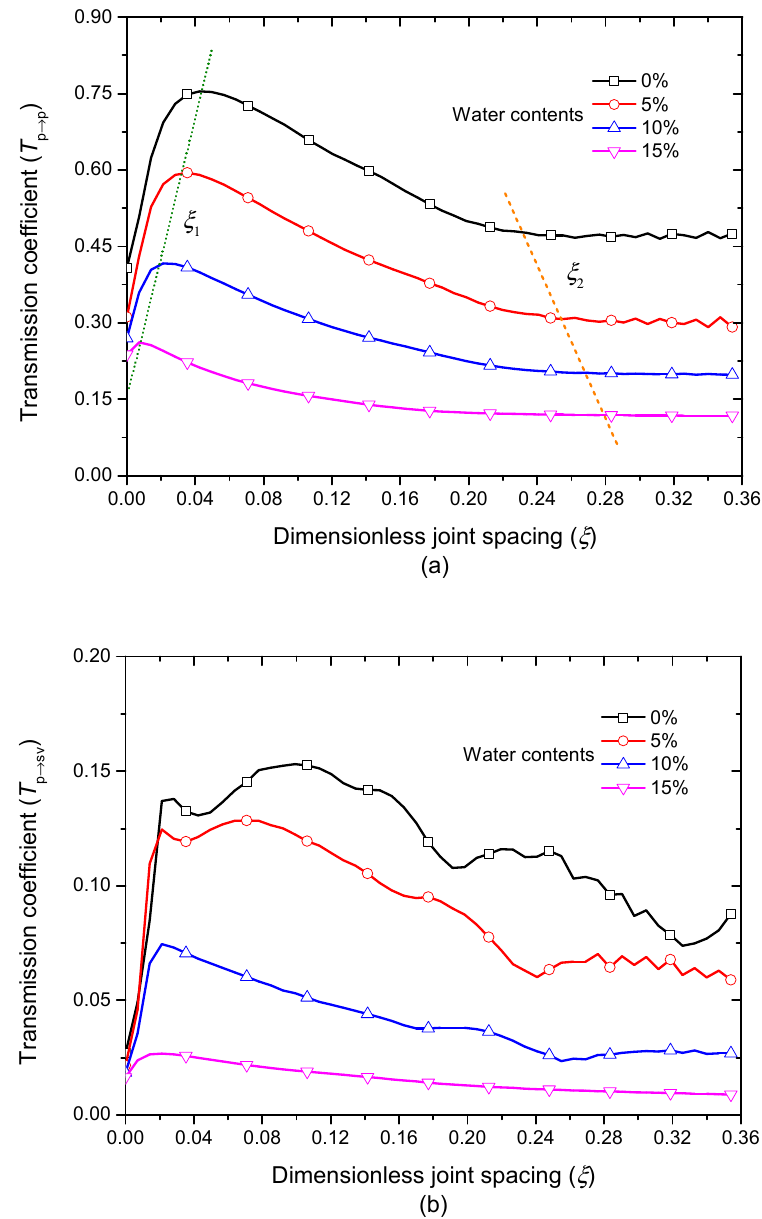
Figure 11. Variation of the transmission coefficient ( a ) T p → p and ( b ) T p → sv versus dimensionless joint spacing ξ after the P wave propagates through four parallel joints considering different water contents. The incident P wave has a central frequency of 42.5 Hz and the incident angle of 20°.